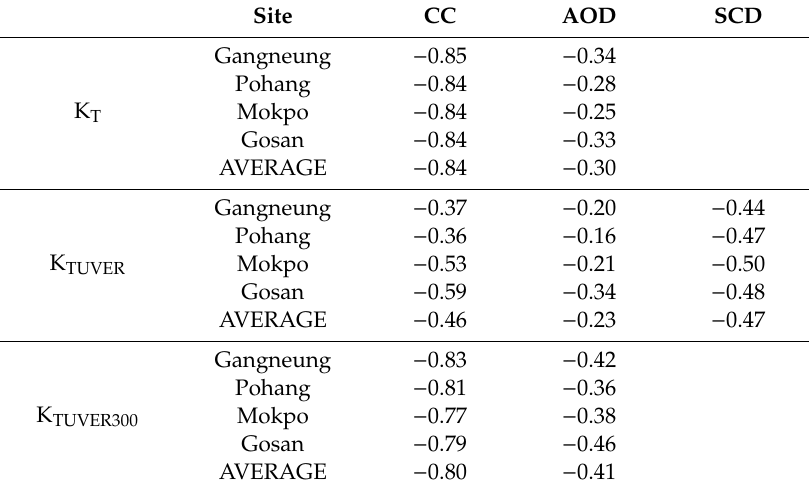
Table 2. Correlation coe ffi cients between clearness indices and atmospheric attenuating factors (CC, AOD, and SCD) at each